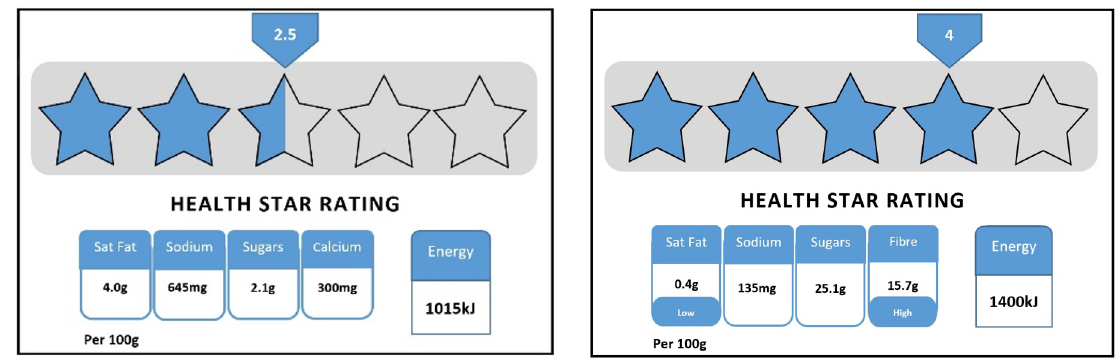
Figure 1. The graphic illustrates an example of the Health Star Rating front-of-pack label for a two-and-a-half-star food and a four-star food. (The Health Star Rating graphic included in the survey is not the o ffi cial Health Star Rating (HSR) logo and was provided as an example at a time when the HSR was in